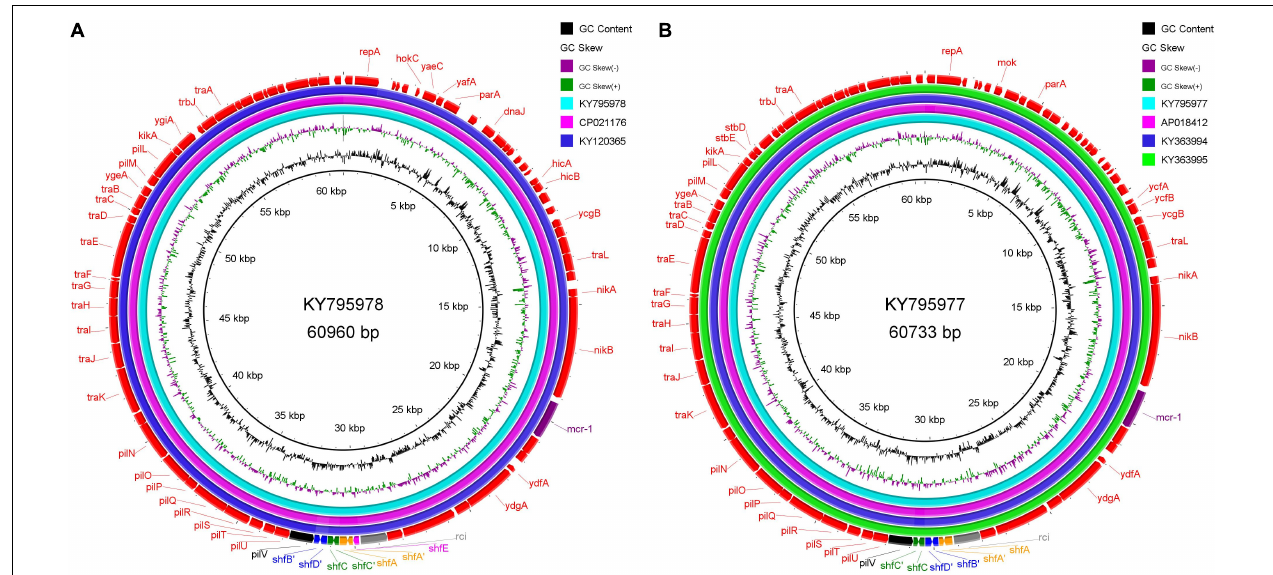
FIGURE 4 | Sequence alignment of IncI2 plasmids with high homology, which were isolated from different regions along the East Asian-Australasian Flyway. (A) KY795978 is used as reference. (B) KY795977 as reference. The alignment was performed using BRIG tool (Alikhan et al., 2011). The outmost arrow ring signifies annotation of the reference sequence. The shufflon structure and the mcr-1 gene are highlighted with outstanding